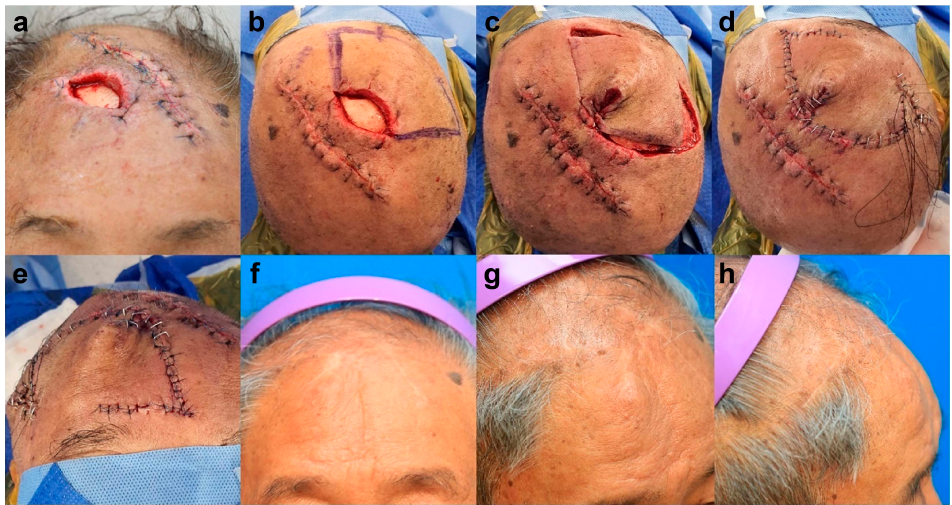
Figure 2. Clinical photographs of case 1. ( a ) Full-thickness skin defect (3.5 cm × 4 cm) with bone exposure in the frontal scalp area. ( b ) Design of a keystone perforator island flap (KPIF) (6 cm × 12 cm) in the temporoparietal scalp and lateral forehead. ( c – e ) Successful coverage of the defect with the Sydney melanoma unit modification and omega variation closure KPIF and skin graft (1.5 cm × 2 cm) for the lateral forehead donor site. ( f – h ) Postoperative photographs after a 10-month follow-up.